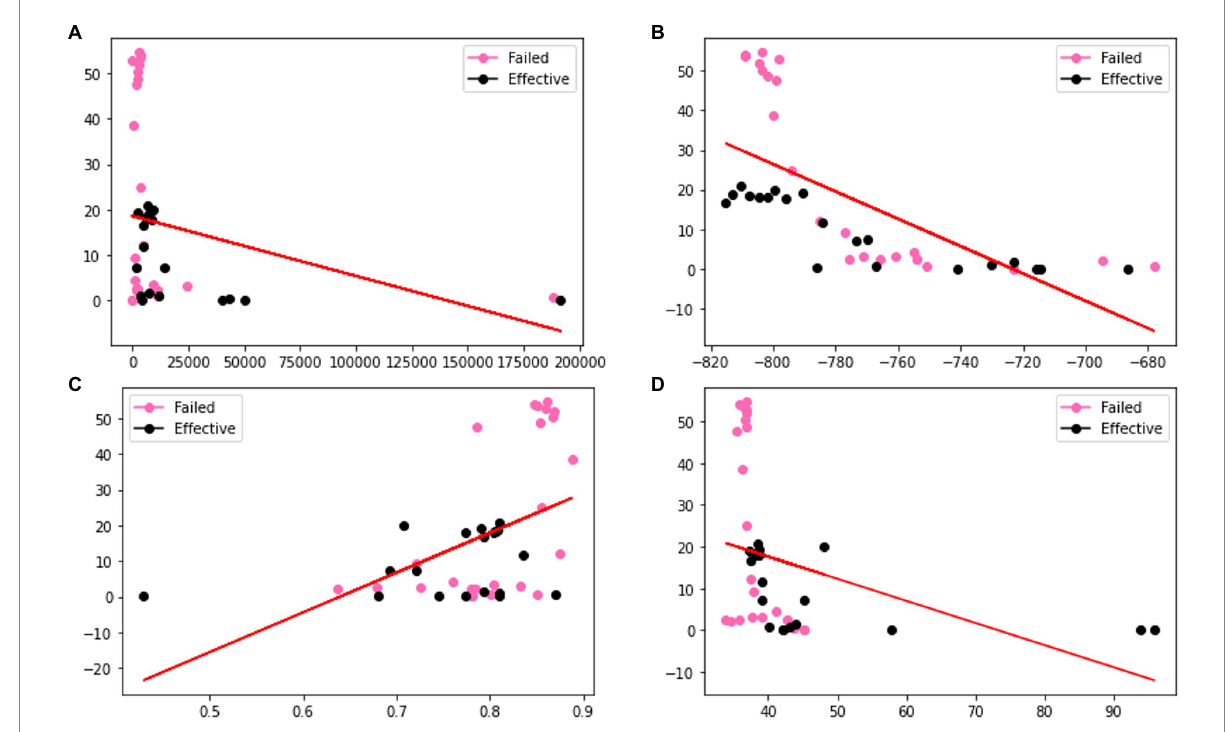
FIGURE 3 Visualization of the distributions of different columns (A) Rct (B) OCP (C) Rsoln (D) m of original dataset. Color coded by the label where pink is a failed coating (normalized corrosion rates greater than 1.000), and black is an effective coating (normalized corrosion rates under 0.999).